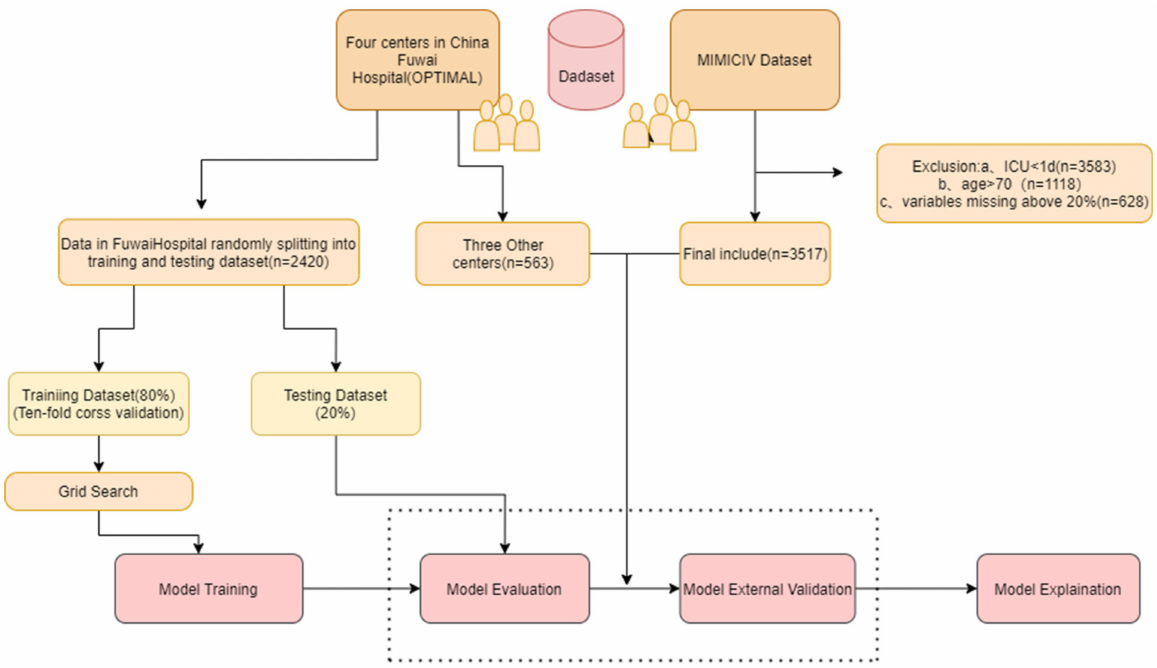
Figure 1. The overall review of this